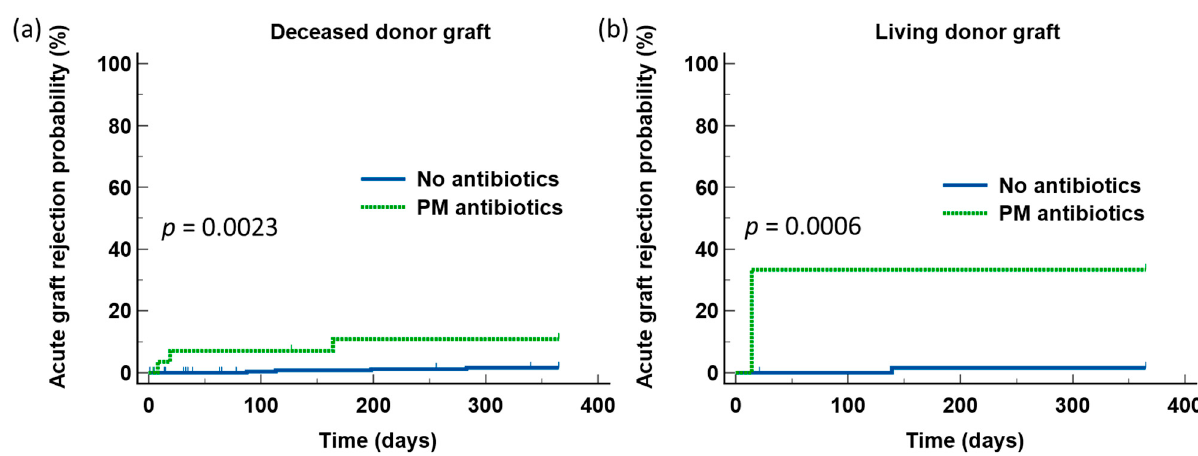
Figure 4. The detrimental effect of piperacillin/tazobactam or meropenem was observed in all the patients, irrespective of whether they received deceased donor kidney grafts ( a ) or living donor kidney grafts ( b ).